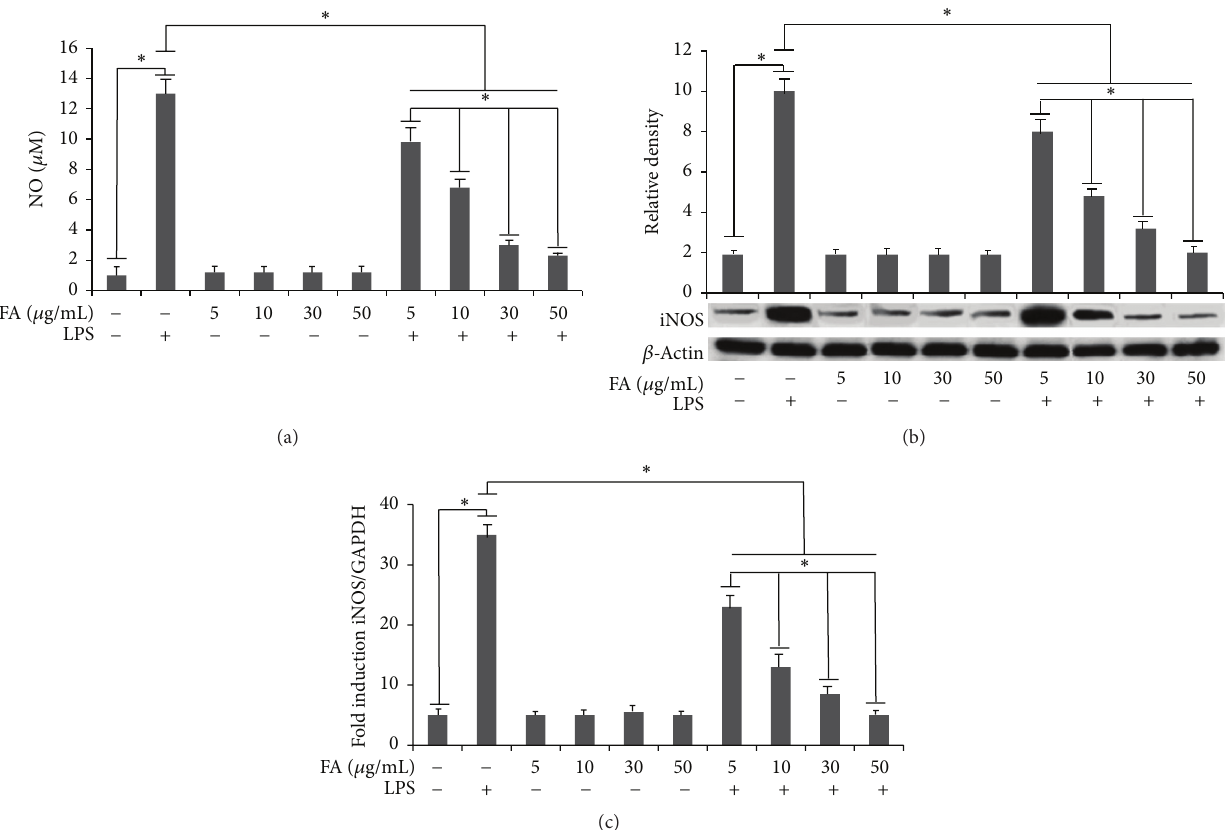
Figure 1: (a) Effects of folic acid on LPS-induced NO production in BV-2 cells. Cells were preincubated in medium containing various concentrations of folic acid (FA) (5, 10, 30, and 50 𝜇 g/mL) for 1h and then treated with LPS (1 𝜇 g/mL) for 24 h. The amount of nitrite in the medium was measured by Griess reaction. (b) iNOS expression in BV-2 cells. Total cellular protein samples were collected and examined by western blotting. Protein levels were determined by measuring immunoblot band intensities by scanning densitometry. (c) iNOS mRNA expression determined by real-time RT-PCR. BV-2 microglial cells were incubated for 6 h with LPS alone, or after 1 h of pretreatment with different amounts of folates. Experimental treatments were analyzed in triplicate and data are expressed as the mean ± SD of five independent experiments. ∗ 𝑝 < 0.05